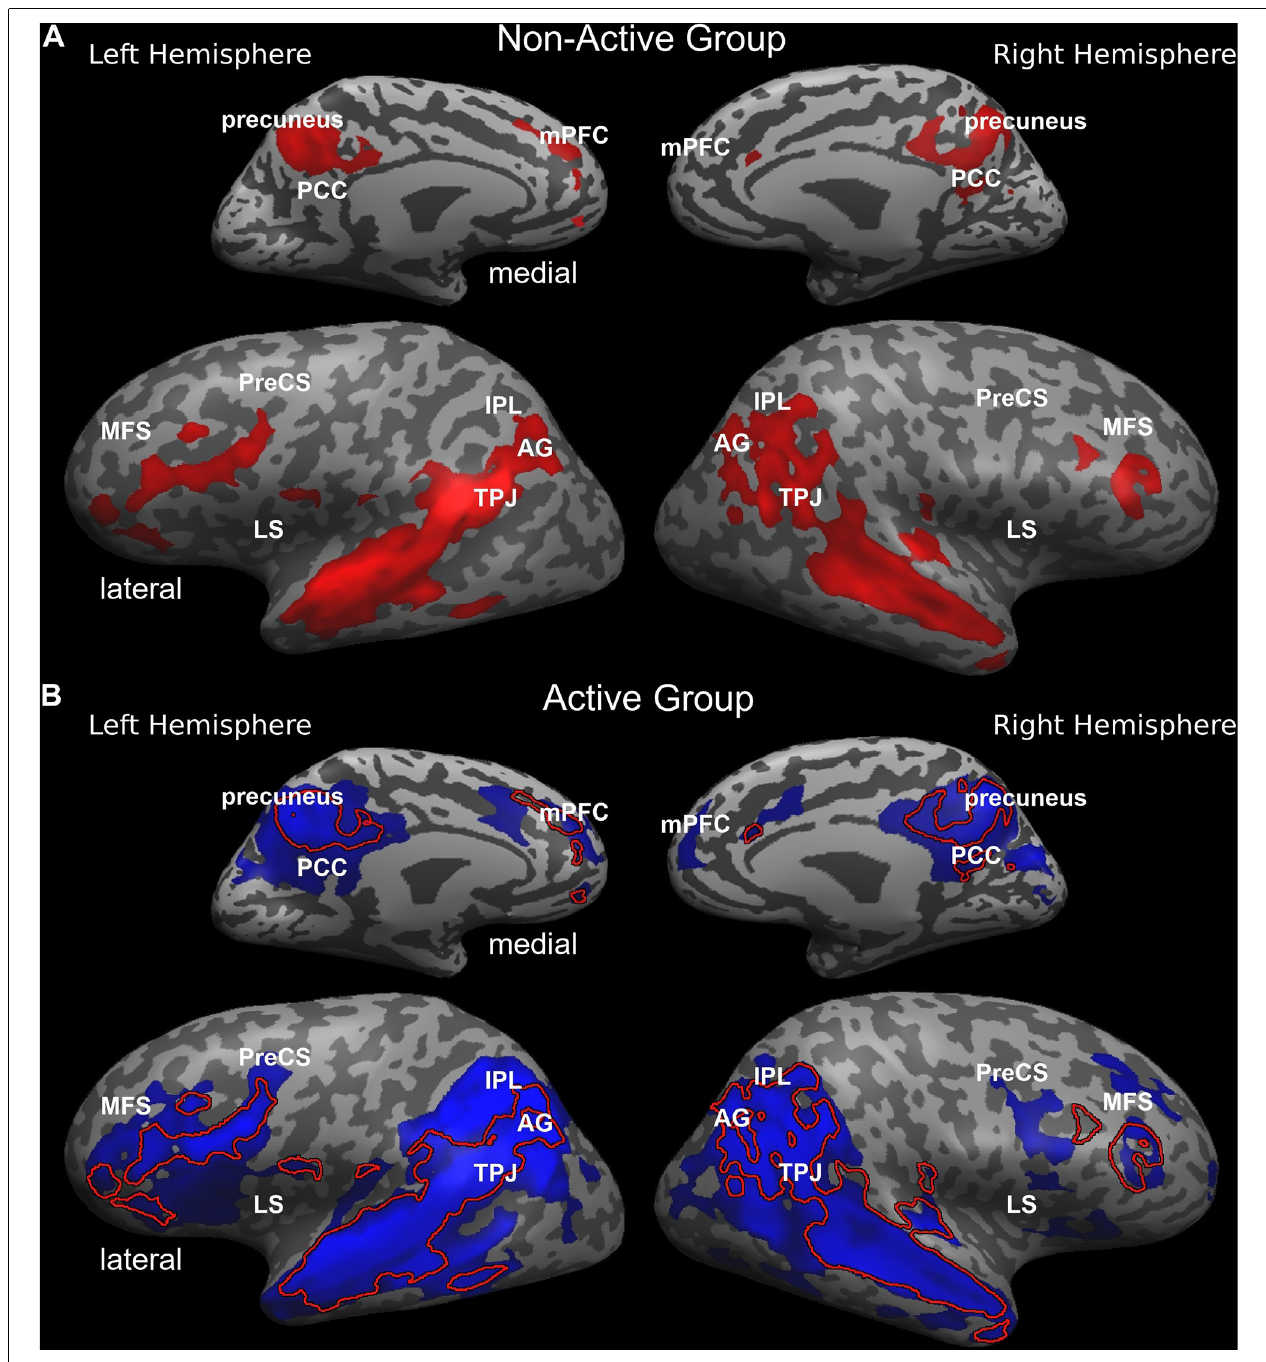
FIGURE 1 | Inter-SC topography during complex information processing in the non-active ( A , red) and active ( B ; blue) groups. Inter-SC maps of the non-active group are overlaid in (B) and represented with a red line. AG, angular gyrus; IPL, inferior parietal lobule; LS, lateral sulcus/insular cortex; MCC, middle cingulate cortex; MFS, middle frontal sulcus; mPFC, medial prefrontal cortex; PCC, posterior cingulate cortex; PreCS, precentral sulcus; TPJ, temporoparietal